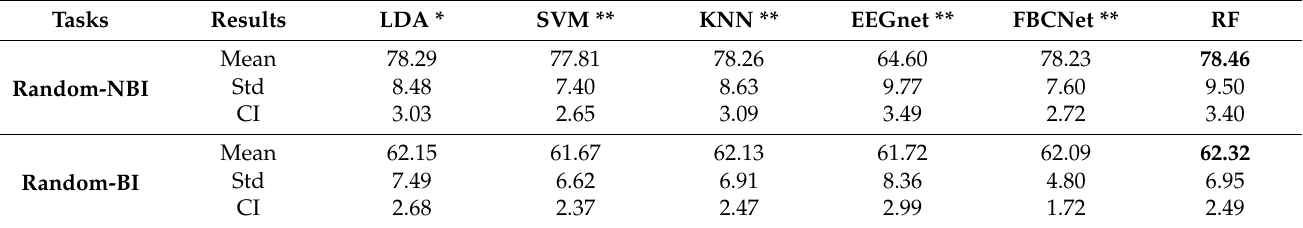
Table 2. A comparison of the different classifiers in the cross-subject experiments.